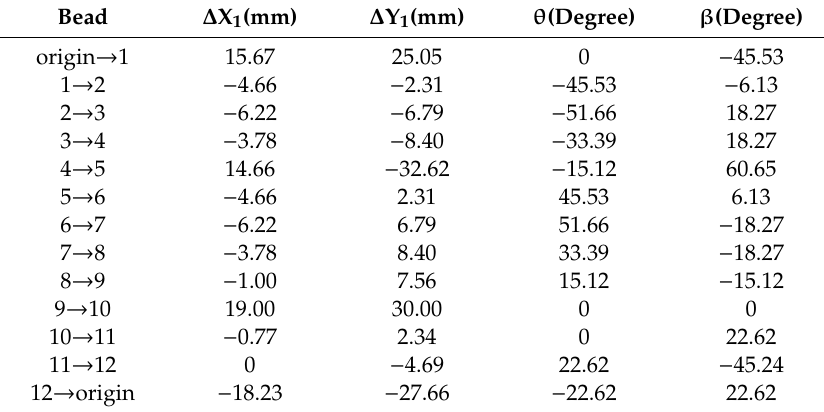
Table 3. The position change table of the welding torch end {O 6 } in {O 1